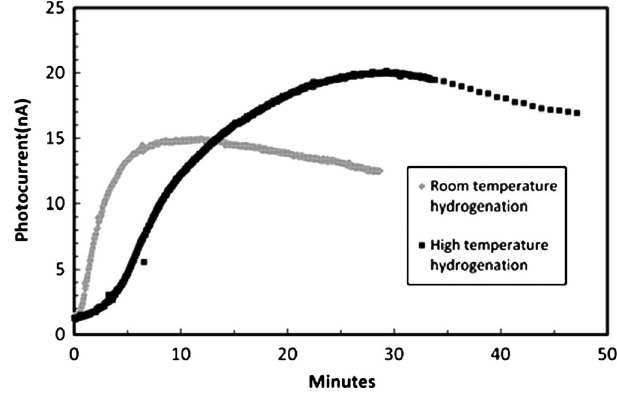
FIG. 1. The trend in the photocurrent during the hydrogenation process.Thedarkcurverepresentsthetrendduringhigh-temperature hydrogenation, and the gray curve is that at room temperature.